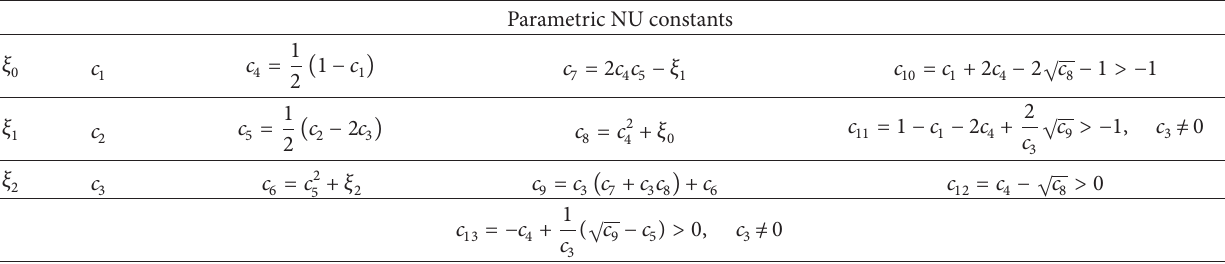
Table 1: The values for the parametric constants of the NU method.